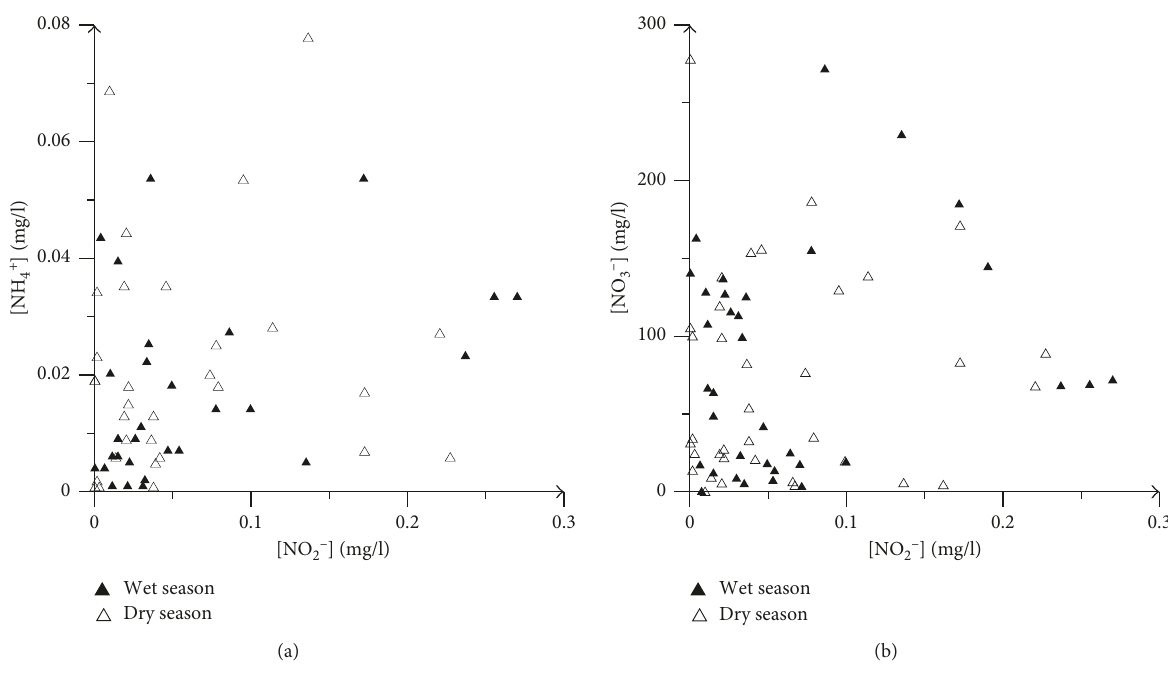
− versus NH 4+ (a) and NO 2